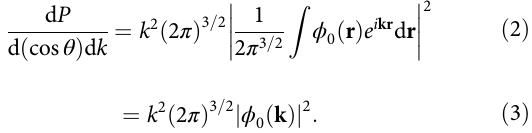
and as such neglects electron – electron correlation by de fi nition.